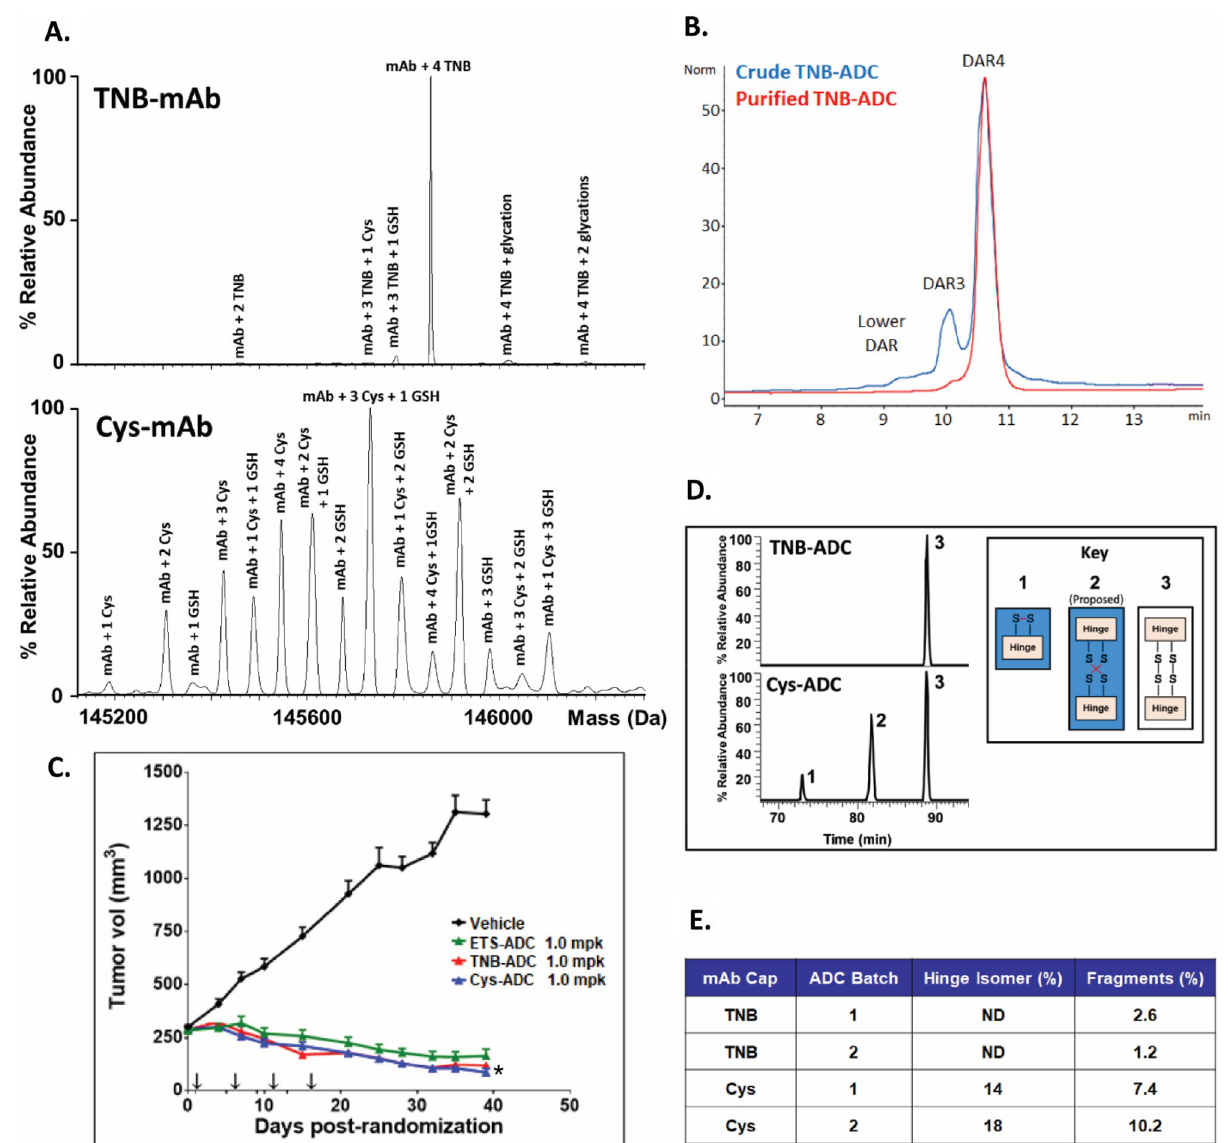
Figure 2. Final antibody generated by TNB-capping and ADC clinical product produced by TSPP selective- reduction/conjugation demonstrate superior quality over those produced by the conventional Cys-capping/ conjugation process. ( A ) Intact molecule ESI MS analysis on TNB-capped and Cys-capped HC-K290C-LC- K183C trastuzumab. Peaks are labeled with the capping species (Cys, GSH or TNB) and number of capped locations (i.e., 1, 2, etc.). The TNB-mAb LC/MS analysis shows nearly all antibodies produced had four TNB caps presented, which was the most desired outcome. ( B ) HIC analysis of ADC produced by TSPP reduction of TNB-mAb followed by conjugation to mcvcPABC0101, before and after preparative HIC purification. ( C ) Tumor xenograft data for TNB-ADC, Cys-ADC, and ETS-ADC each dosed at 1 mg/kg Q4Dx4 (arrows on x-axis) after initial staging and randomization in an N87 nude mouse xenograft model. n = 10–15 mice per group. Data are reported as mean ± SEM * P < 0.05 for TNB-ADC as compared to Cys-ADC. ( D ) Extracted ion chromatograms of intrachain and interchain disulfide bonded forms of the hinge region demonstrated the high quality of ADCs produced through TNB-capping strategy versus the Cys-capping strategy. The